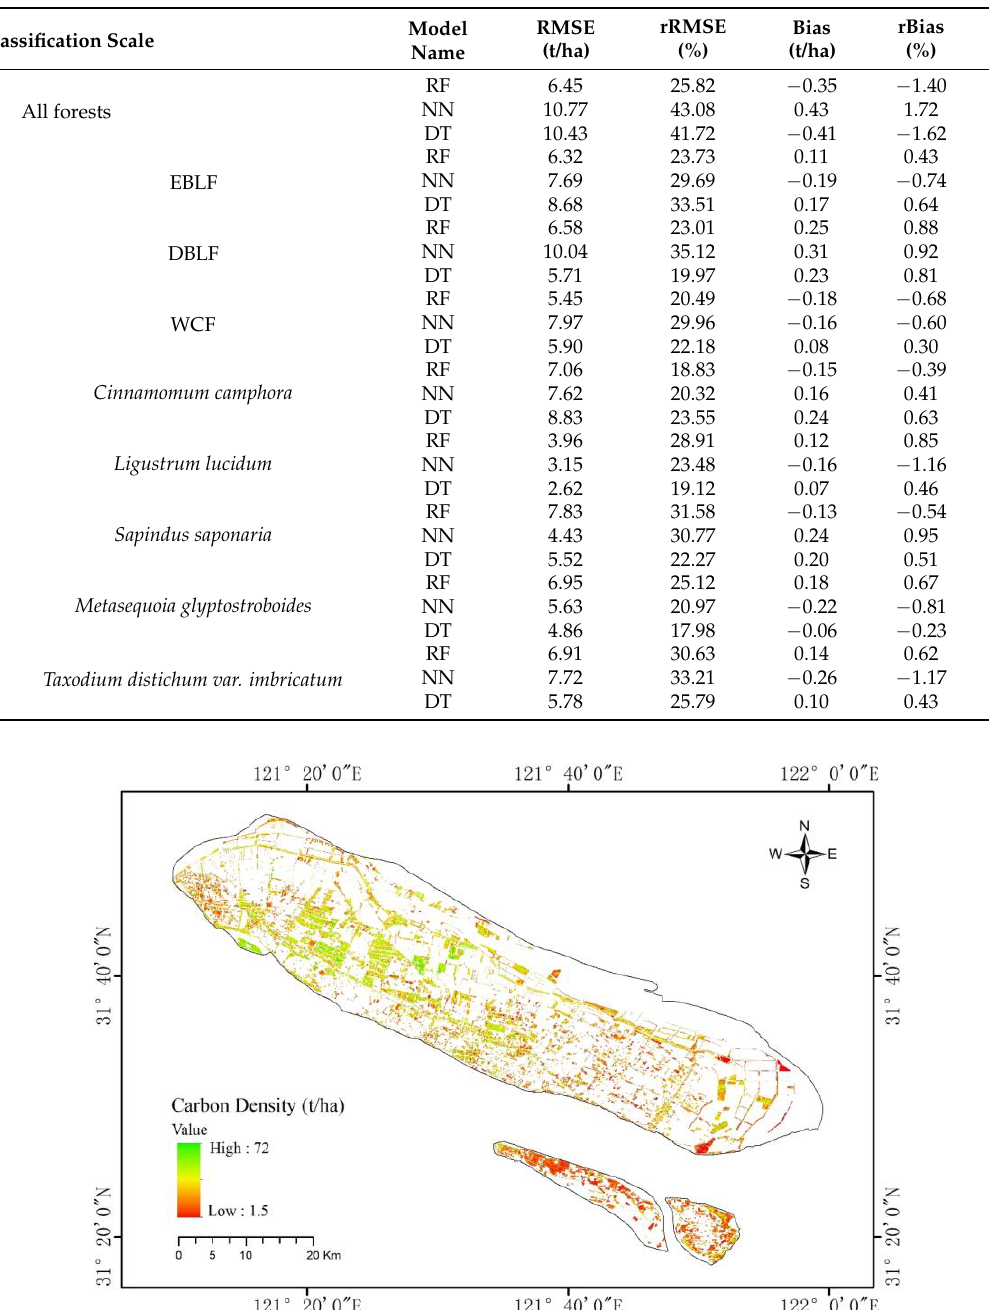
Table 3. Accuracy value comparisons of carbon density among machine learning models and different forest classification schemes. EBLF: evergreen broad-leaved forest, DBLF: deciduous broad-leaved forest, WCF: warm coniferous forest; RF: random forest model, DT: decision tree model, and NN: neural network model.